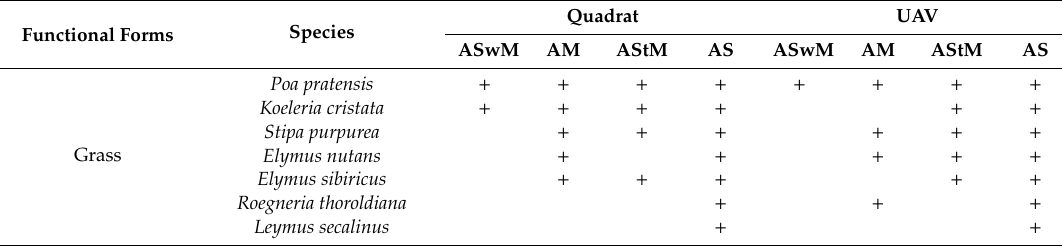
Table A1. List of recorded species in four typical alpine grasslands of Shule River Basin by the UAV method and Quadrat